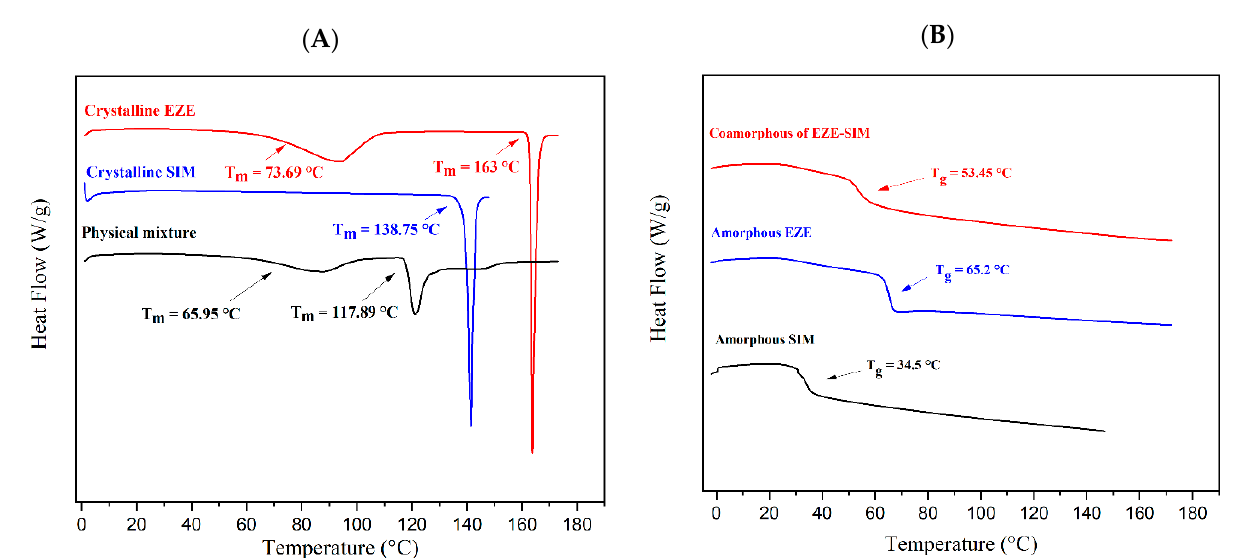
Figure 2. The DSC traces of crystalline/amorphous EZE, SIM, PM, and co-amorphous. ( A ) Crystalline EZE, crystalline SIM, SIM-EZE PM. ( B ) Amorphous EZE, amorphous SIM, SIM-EZE CO.